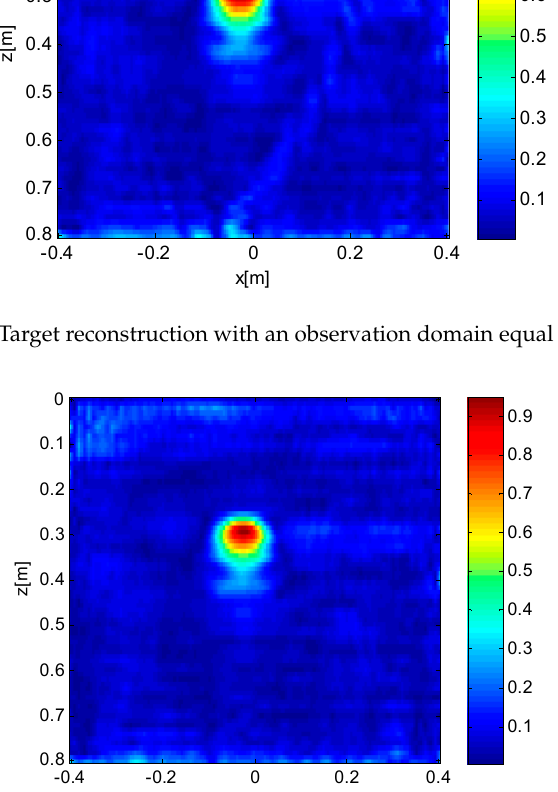
Figure 5. Target reconstruction with an observation domain equal to 2.4 m.